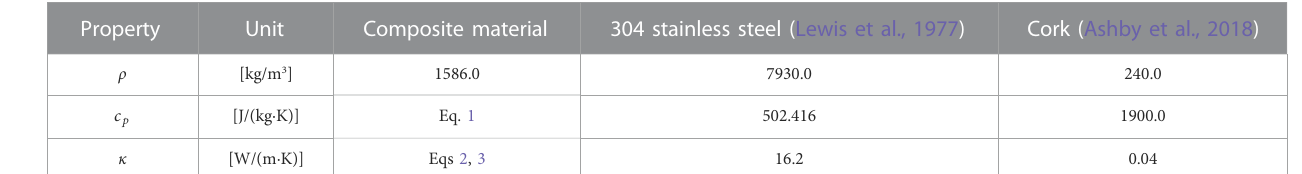
TABLE 1 Thermal properties of composites material, steel, and cork.